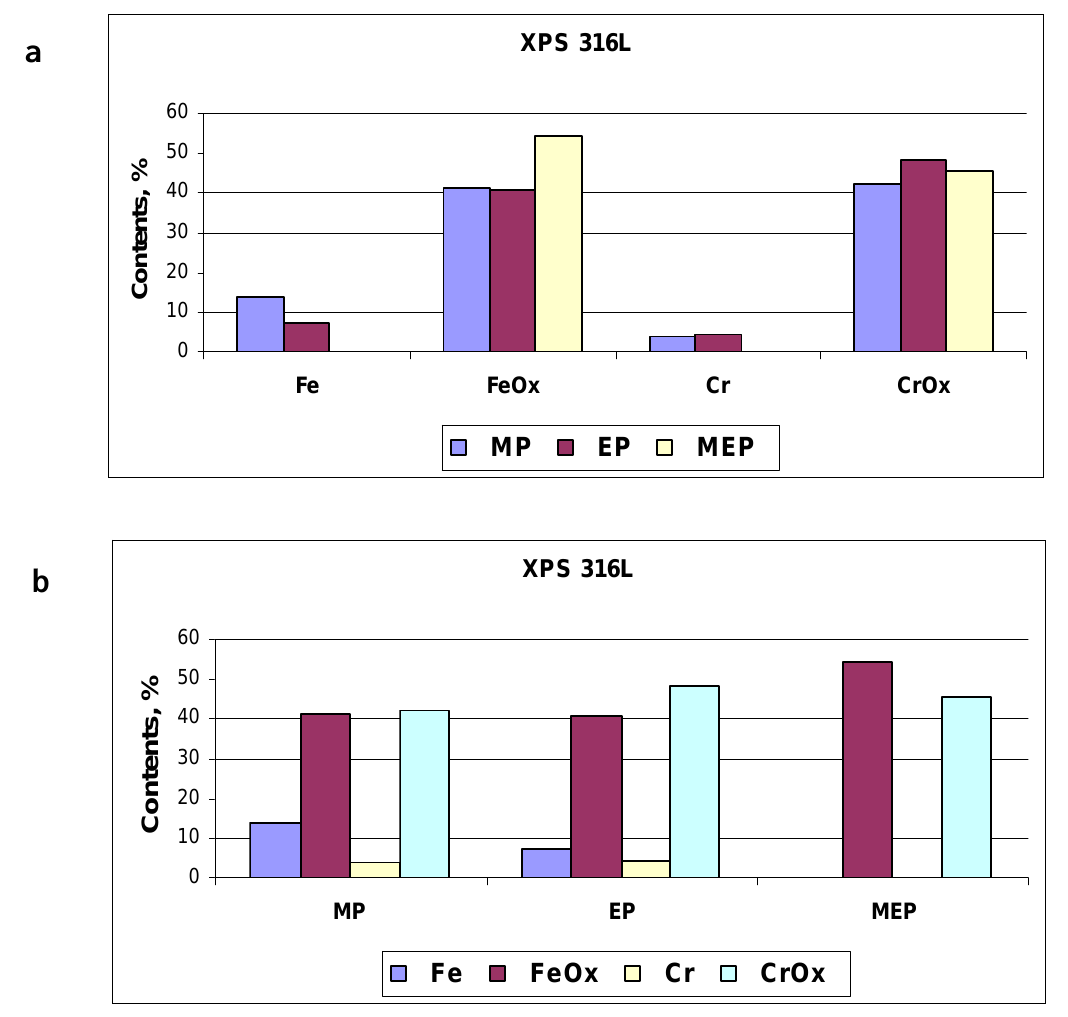
Figure 11. Calculated results of surface film composition on 316L SS sample: (a) revealing the presence or absence of free atoms and oxides, (b) dependent on kind of treatment, MP, EP and